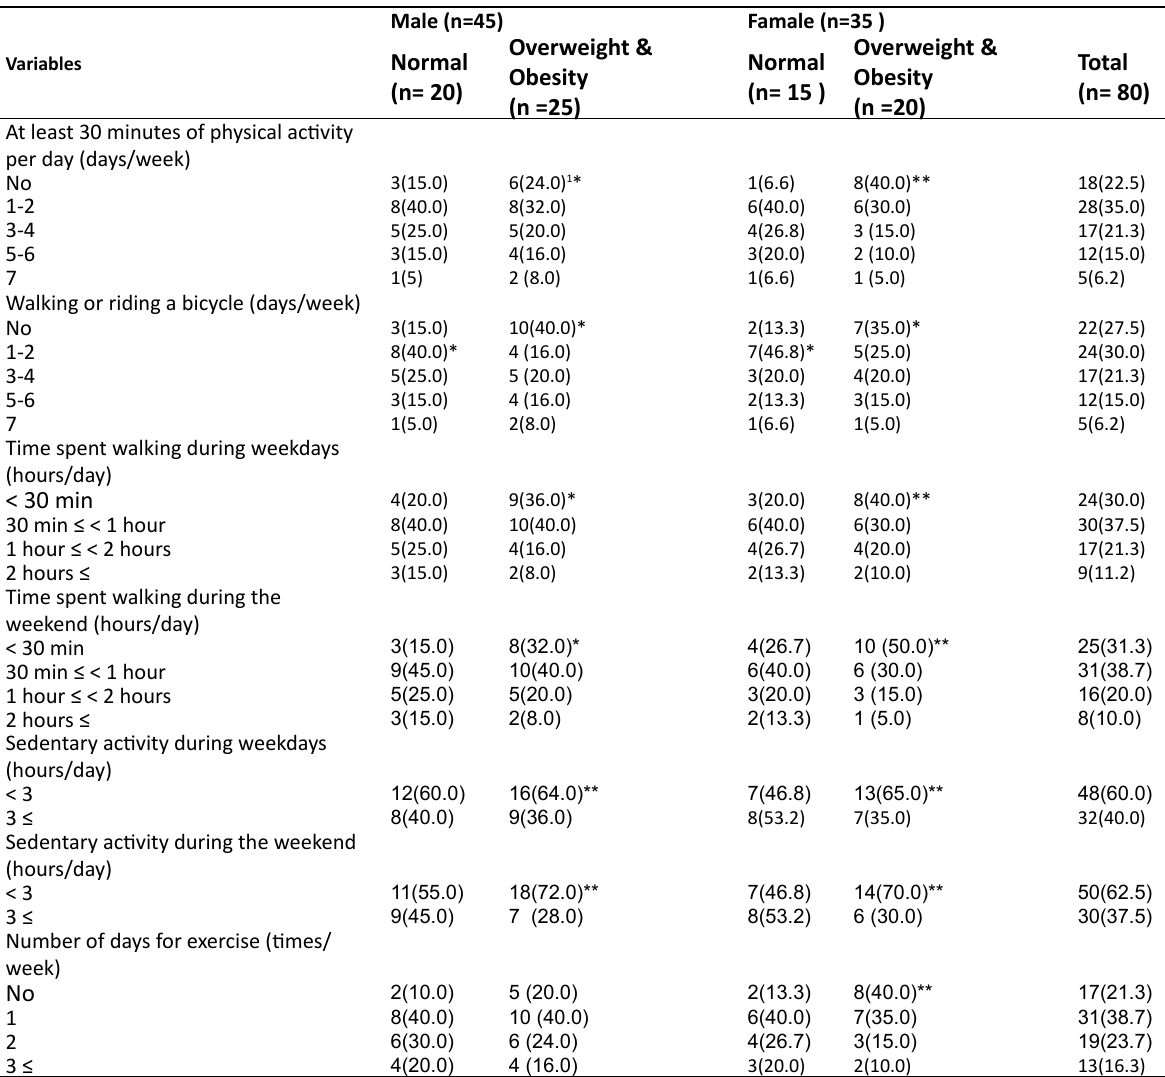
Table 3: The level of physical activity according to obesity status of Sedanter Individuals who are Members of Fitness